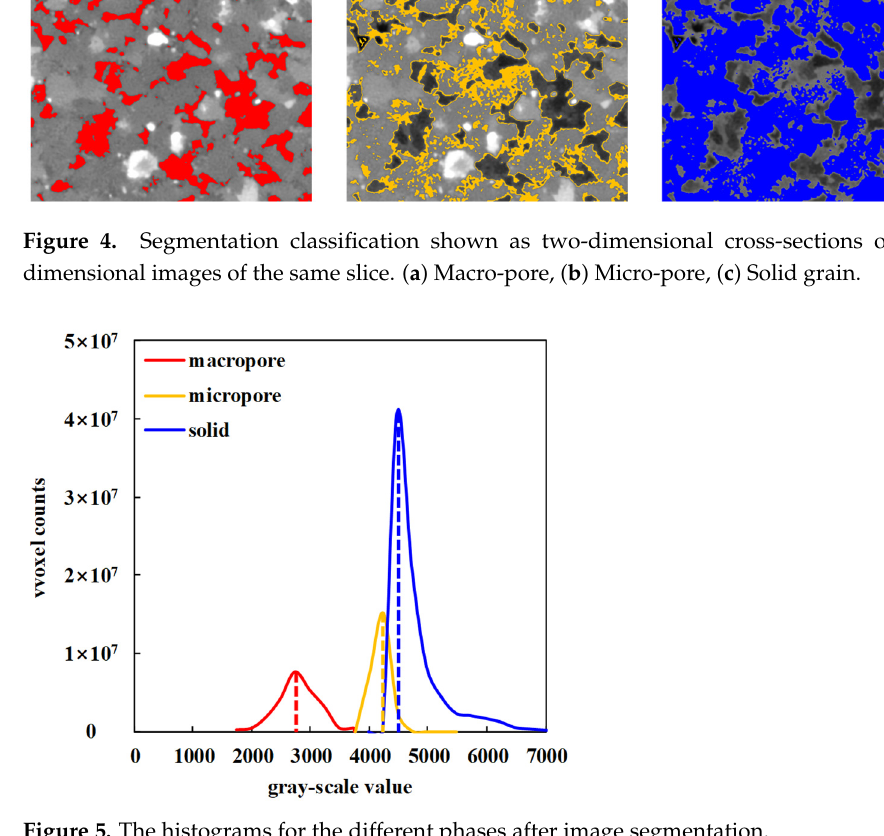
Figure 5. The histograms for the different phases after image segmentation.